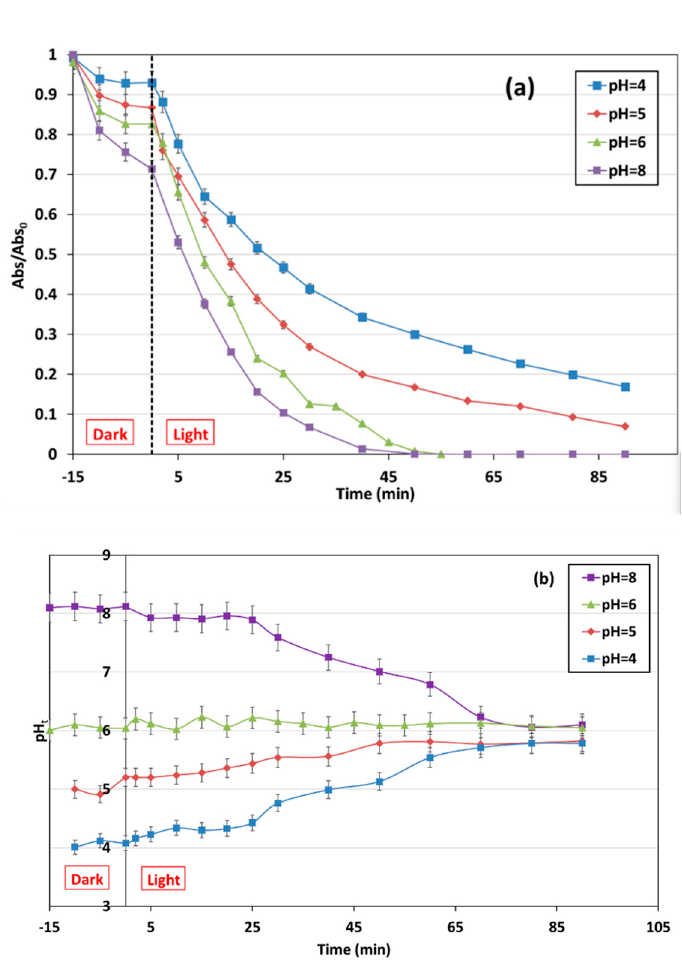
Figure 6. ( a ) Influence of the aqueous solution pH on the degradation of MB (C 0 = 60 mg/L; DTiO 2 = 1 g/L; temperature = 20 ± 2 °C); ( b ) variation of pH in solution through the MB photodegradation process (C 0 = 60 mg/L; DTiO 2 = 1 g/L; temperature = 20 ± 2 °C).